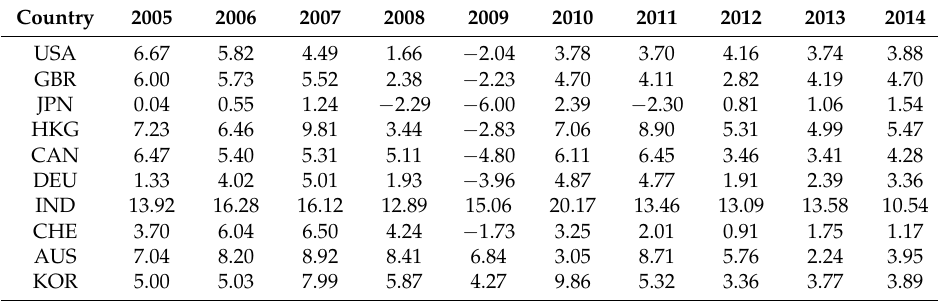
Table B1. GDP nominal growth per country ζ ( % ) : 2005–2014.